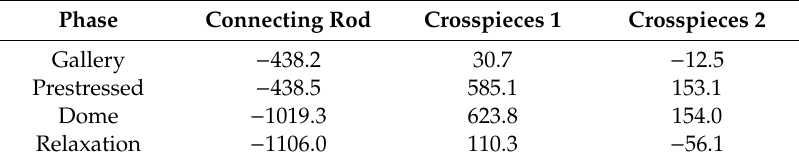
Table 18. Axial forces in kN on connecting rods and crosspieces.